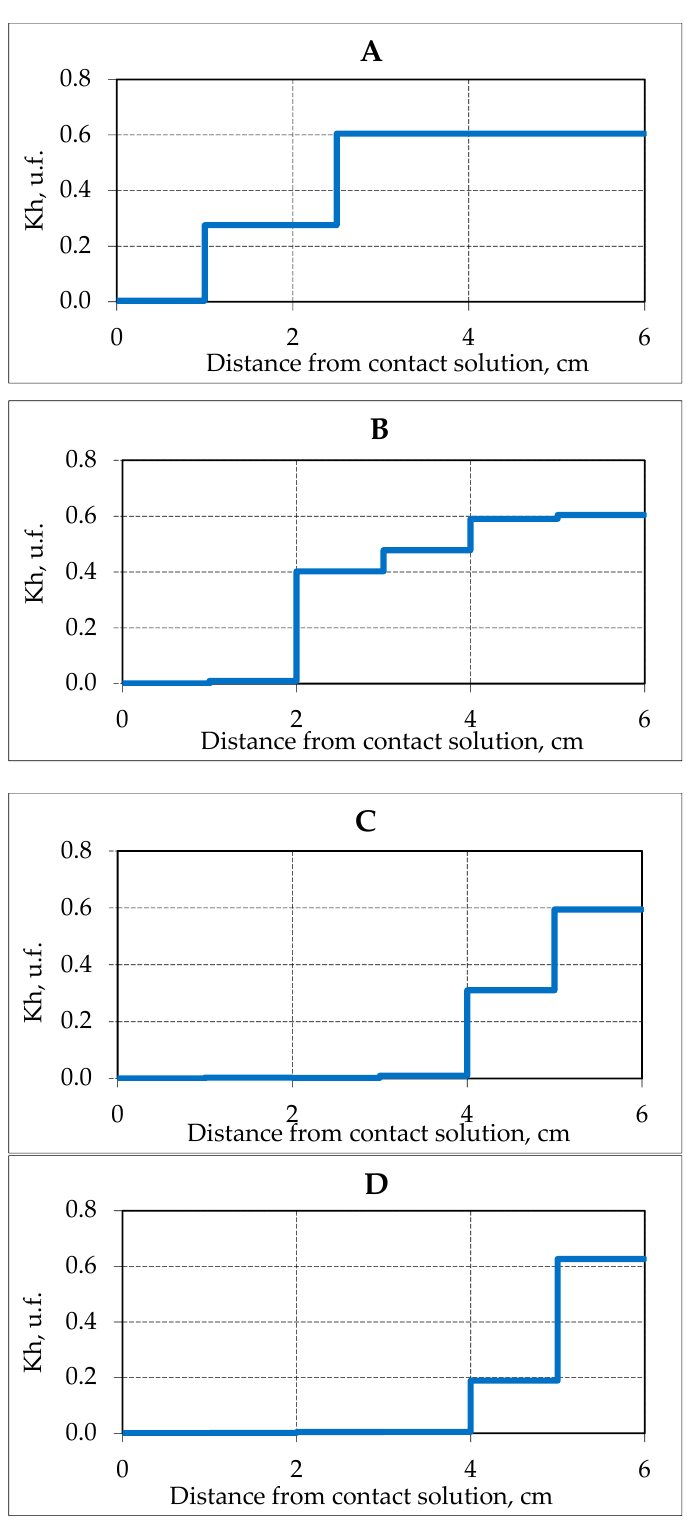
Figure 3. The change in the hydration coefficient (K h ) in frozen hydrate saturated samples of sand (sand 1, W = 14%) in time when interacting with 0.2 N NaCl salt solution at a temperature of − 4 °C. A – D is the time of interaction with the salt solution, respectively, 3.9, 17.5, 25.5 and 28.8 h.